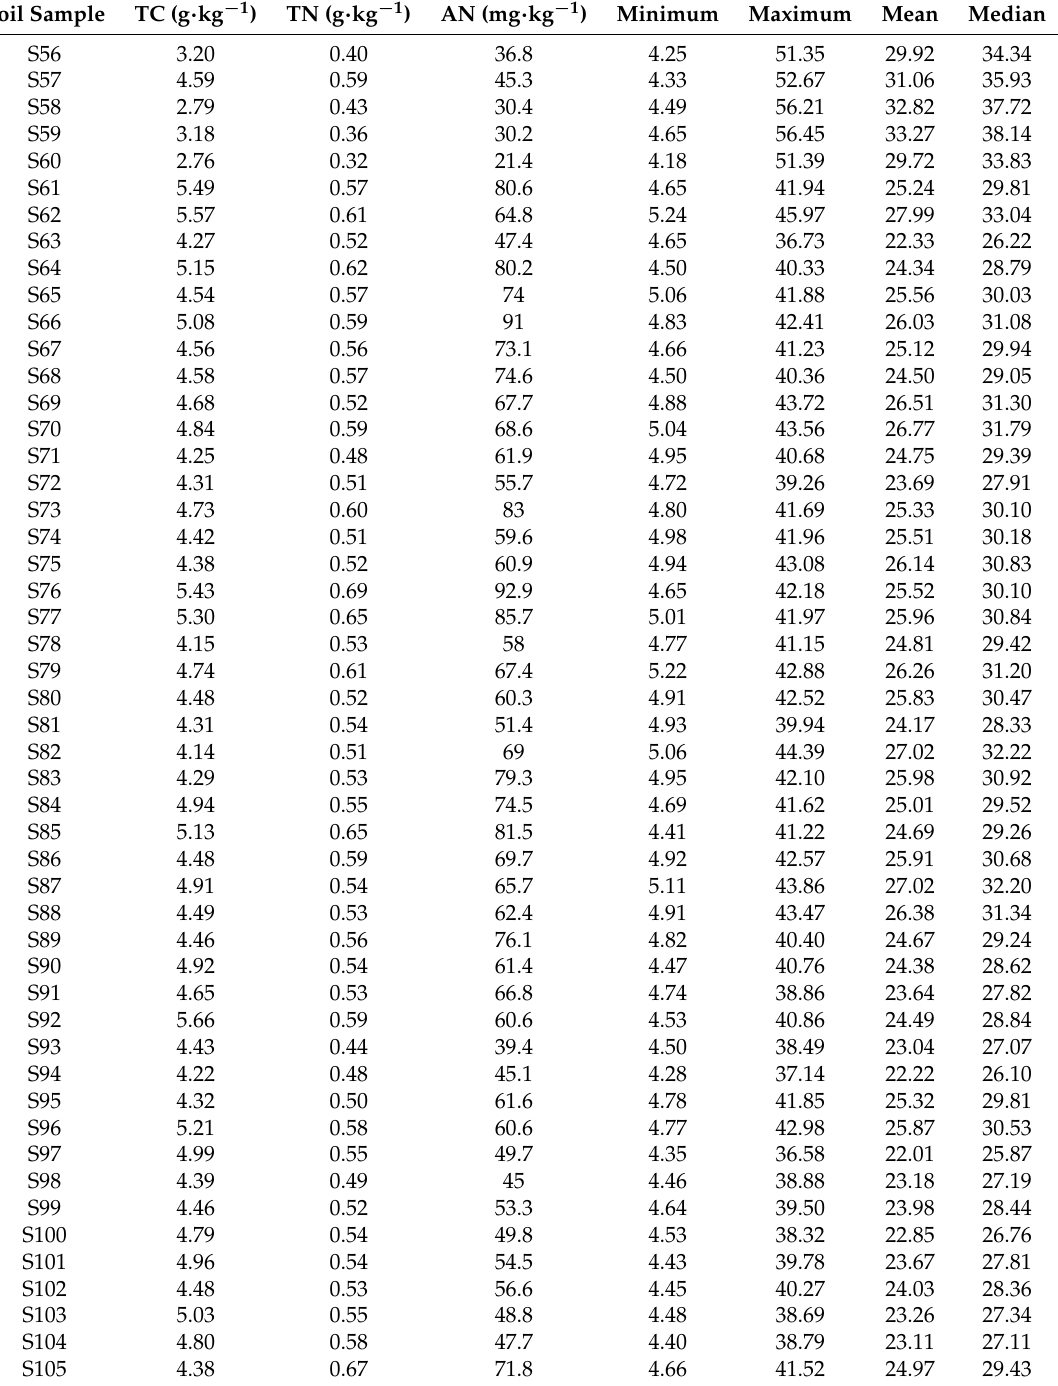
Table A2. Basic information on samples from S56 to